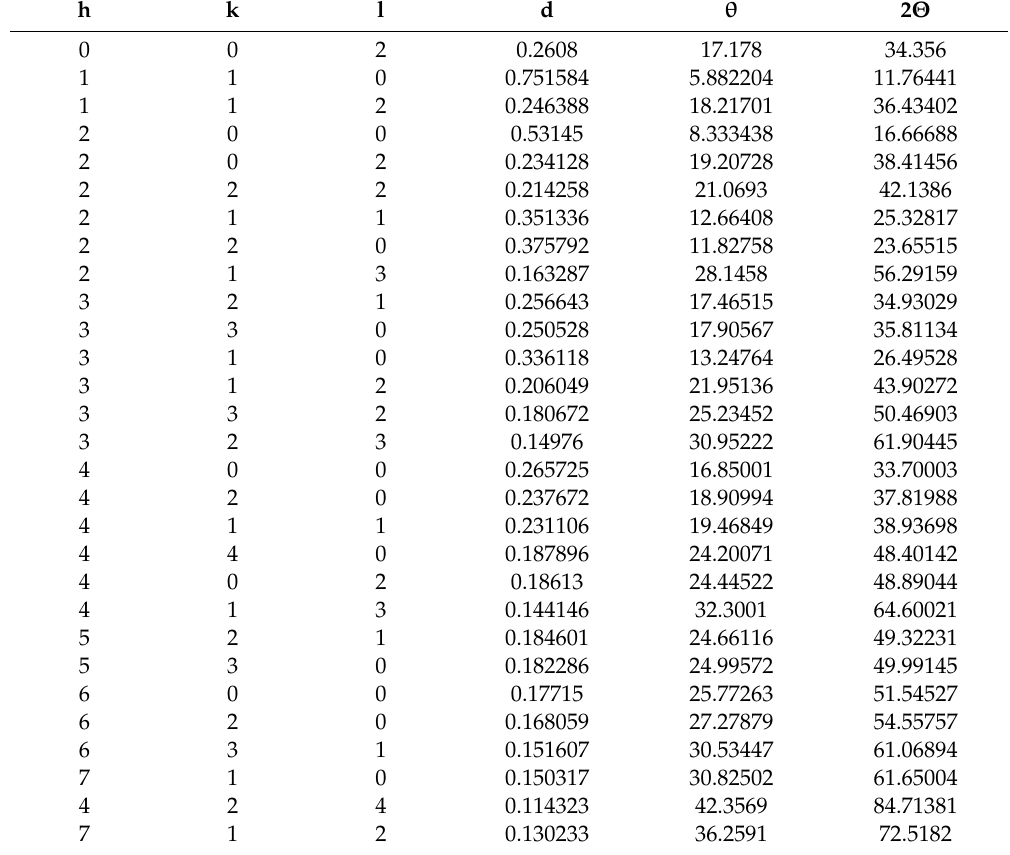
Table A1. Calculated peak positions for Nb 5 Sn 2 Al based on the lattice constants provide in [25]. Where h, k, l refer to the Miller indices, d corresponds to the d-spacing and θ , 2 θ refer to the di ff raction